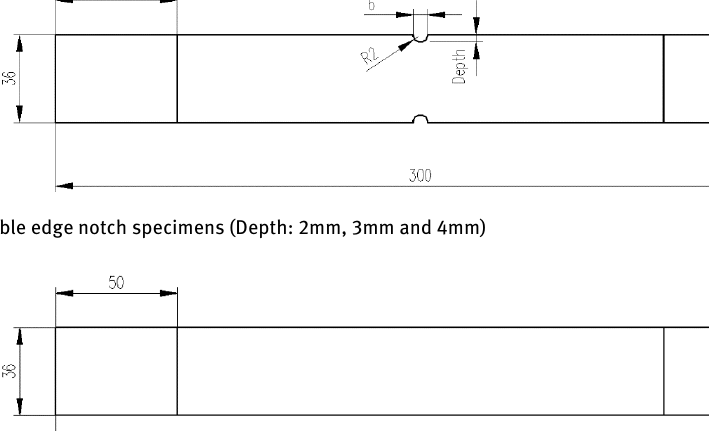
of 250 (length) × 25 (width) ×2.8 (thickness) mm was ap-